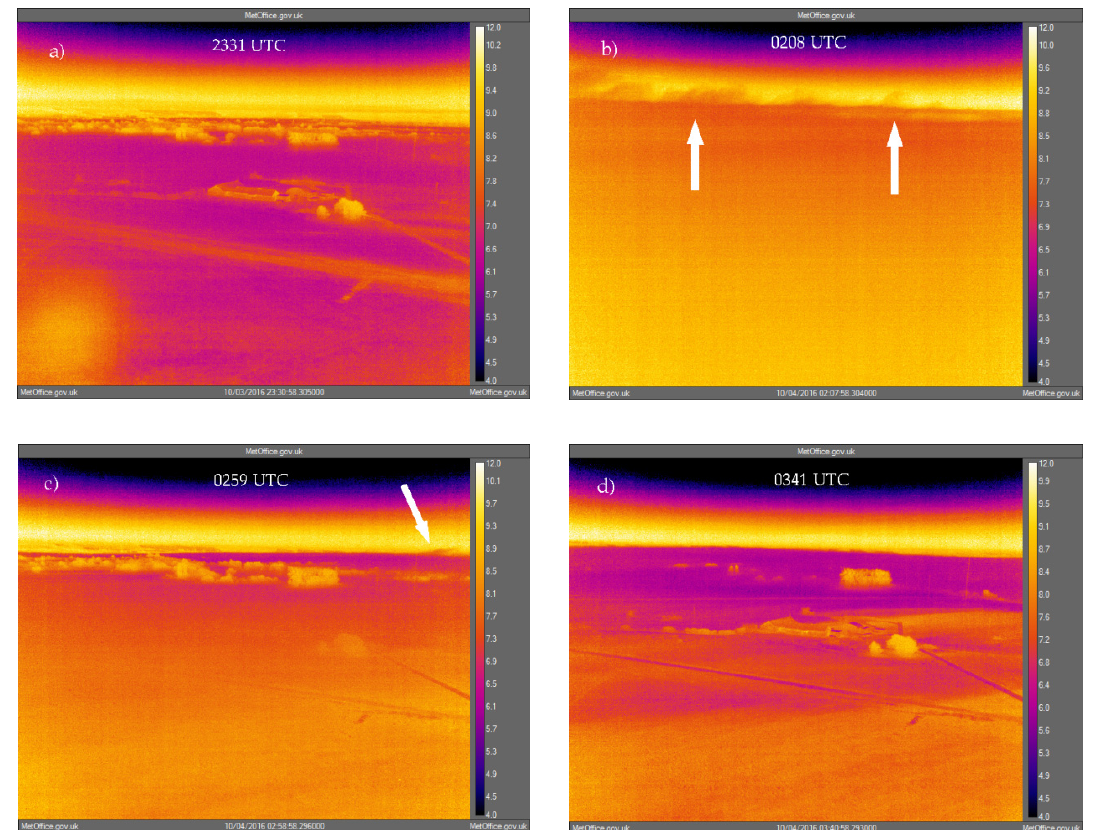
Figure 6. IR images at various stages of a turbulent fog layer occurring on 3-4 October 2016 at, ( a ) 2331 UTC, ( b ) 0208 UTC, ( c ) 0259 UTC and ( d ) 0341 UTC, as described in the text. White arrows indicate regions of mixing. The round orange area in the bottom left of panel ( a ) is an insect on the camera housing